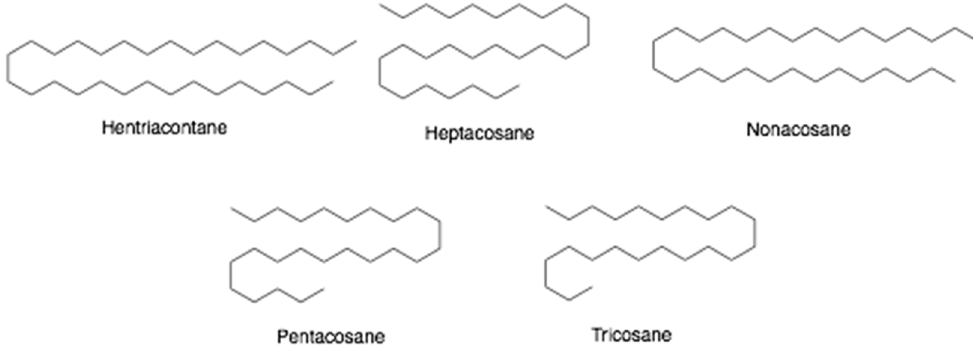
Figure 9. Chemical structures of hydrocarbons found in beeswax.